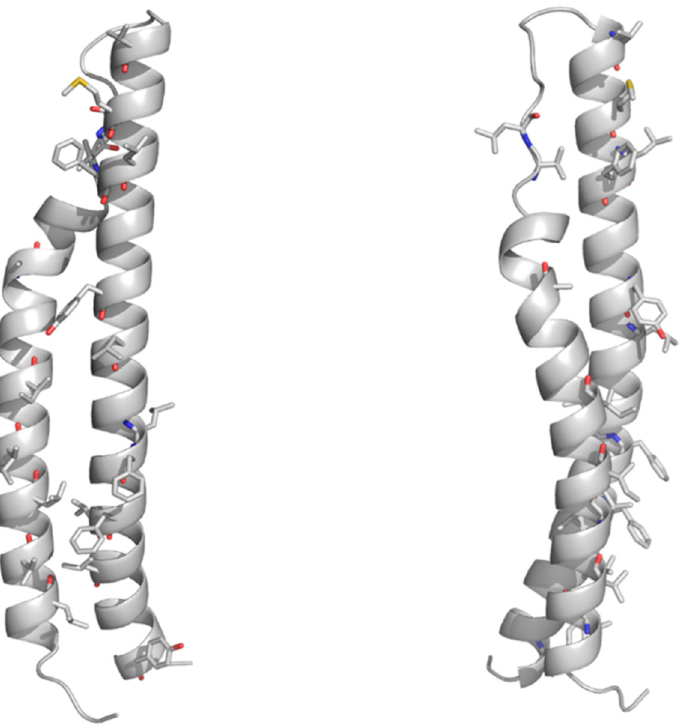
Figure 3. Cartoon representations of the homology model of the PE domain of PE_PGRS33. Front and side views are reported on left and right sides, respectively. The model was computed with MODELLER using the structure of the PE25 domain from a type VII secretion system of Mycobacterium tuberculosis ( Mtb ) as a template (PDB core 4w4k, sequence identity 37%). Hydrophobic and aromatic residues are drawn in stick representation.